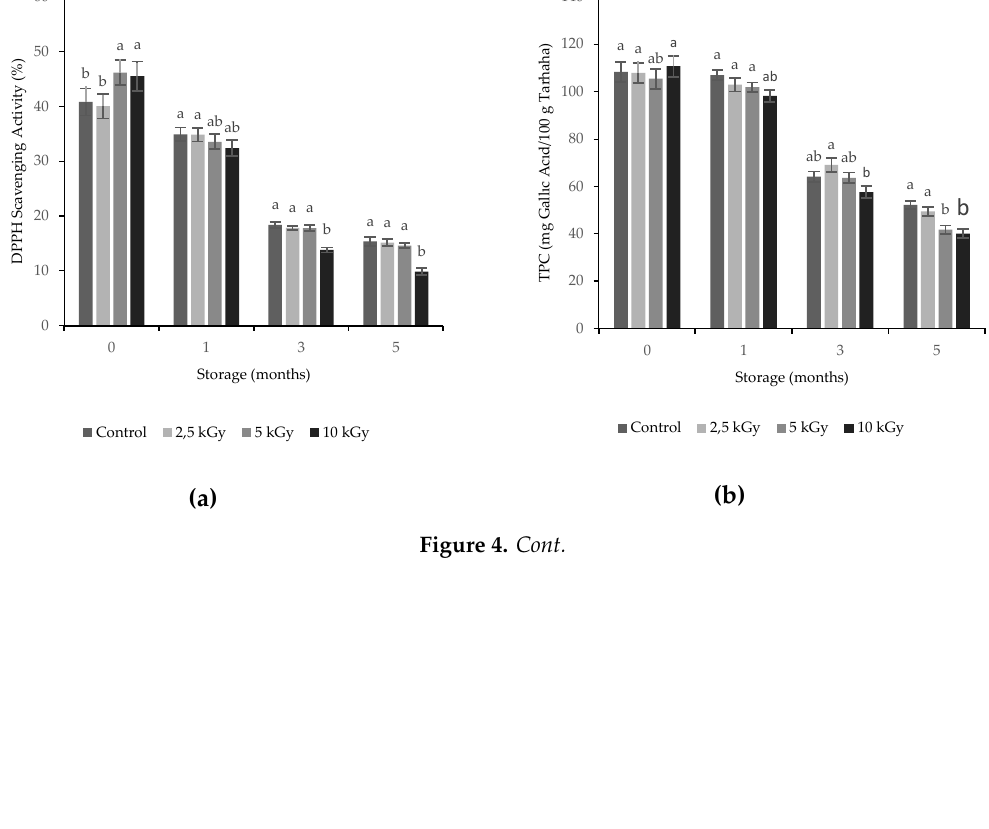
Figure 3. The consistency coefficient of soups prepared with using irradiated and control tarhana 235 samples. Capital letters represent the p < 0.05 level of statistical difference between the storage times 236 of the tarhana samples, while the lower-case letters show the p < 0.05 level of statistical di ff erence between the irradiation doses.